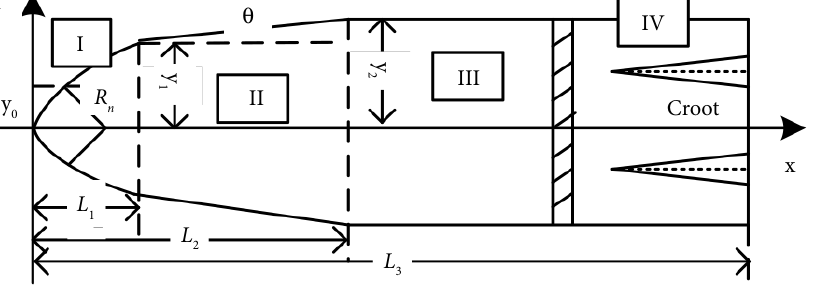
Figure 2. Parameterized vehicle of slender body with power-law rotating.